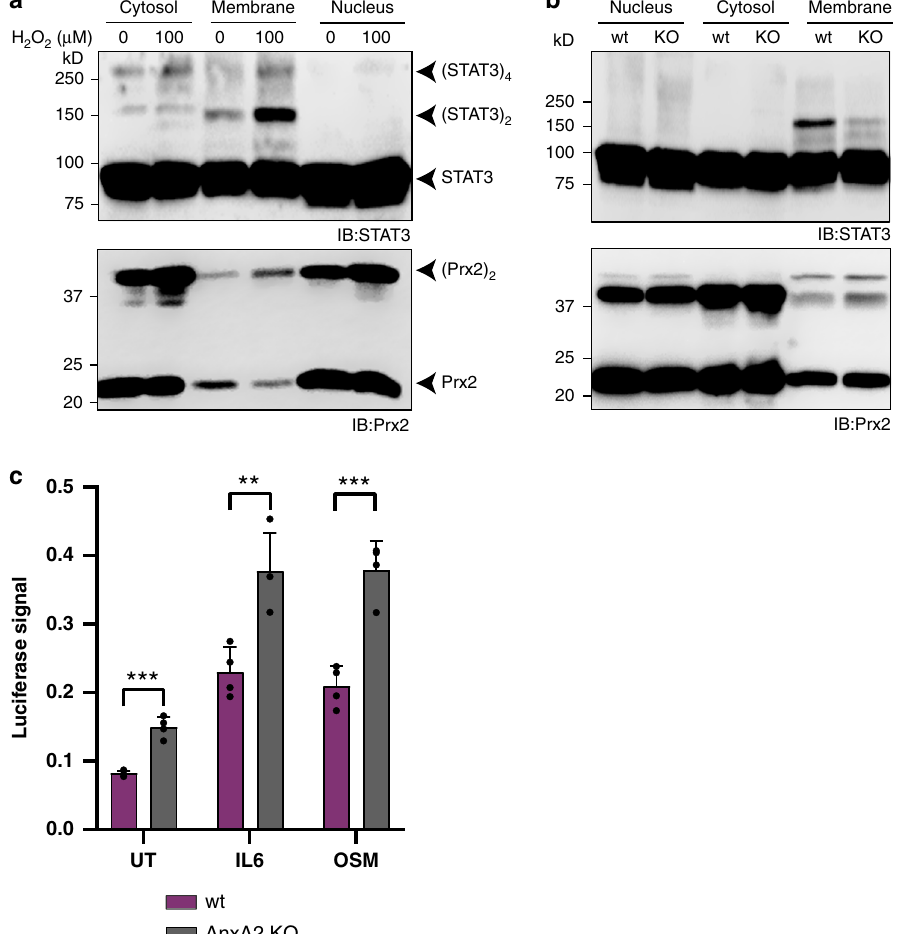
Fig. 5 AnxA2-dependent STAT3 oxidation occurs at the membrane and affects the transcriptional response. a STAT3 oxidation is associated with membranes. HEK293 MSR cells were pulsed with 100 µ M H 2 O 2 for 2 min and then fractionated into cytosol, membranes, and nuclei. The corresponding reducing immunoblot is shown in Supplementary Fig. 5a. The blots are representative of n = 3 independent experiments. IB immunoblot. Source data are provided as a Source data fi le. b Membrane-associated STAT3 oxidation depends on AnxA2. HEK293 MSR wild type and AnxA2 KO cells were fractionated into cytosol, membranes and nuclei. The corresponding reducing immunoblot is shown in Supplementary Fig. 5b. The blots are representative of n = 3 independent experiments. IB immunoblot. Source data are provided as a Source data fi le. c AnxA2 de fi ciency increases STAT3-dependent transcription from the serum inducible element (SIE) promotor. STAT3 signaling was induced by either IL-6 or OSM treatment and SIE promotor activity was measured with a luciferase reporter. Bars represent the mean (±SD) of n = 3 biological replicates. ** p < 0.01; *** p < 0.001; based on a